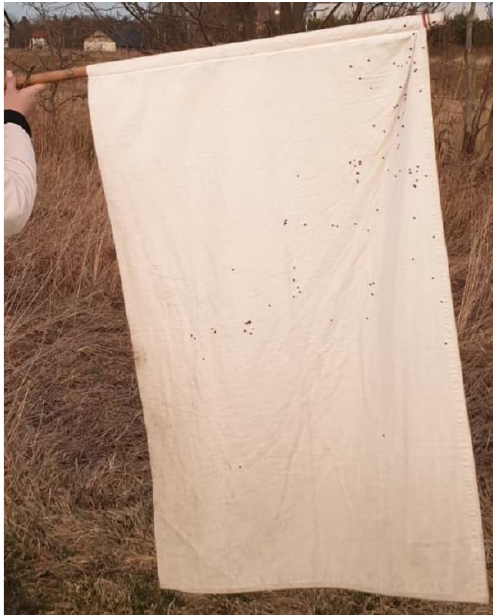
Figure 5. Dermacentor reticulatus ticks collected in plot 41. A total of 96 adult specimens were collected in an area of 10 m 2 .